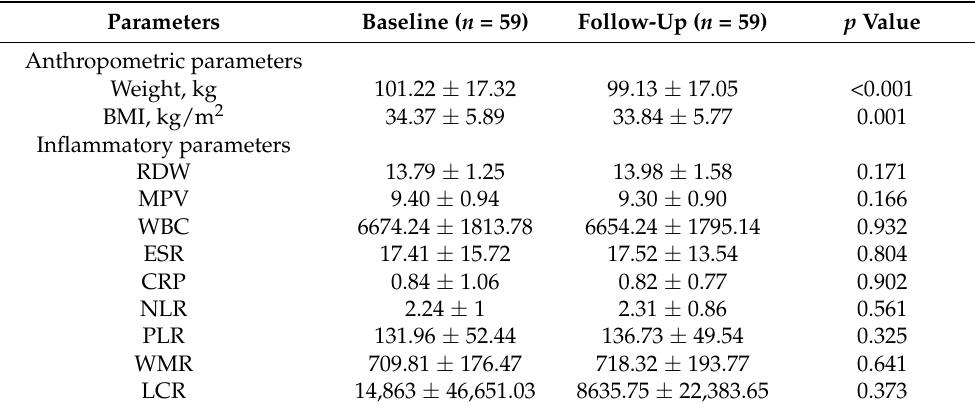
Table 3. Anthropometric and inflammatory parameters, at baseline and after 8 weeks of CPAP (moderate and severe OSA).